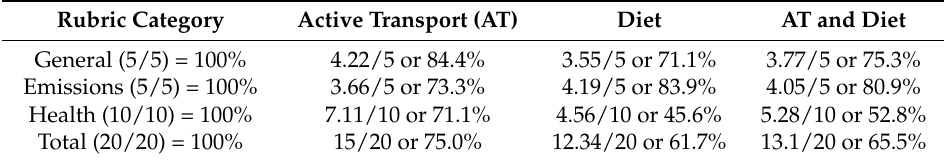
Table 5. Biases, limitations, and uncertainties rubric scores by lifestyle-related mitigation category.